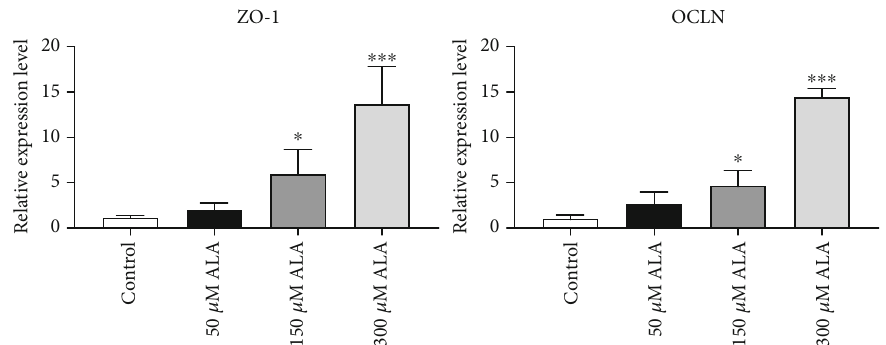
Figure 2: E ff ects of ALA on the mRNA expression of mucosal tight junction factors of NCM460 cells during injury repair. Quantitative real- time PCR analysis of tight junction protein 1 (ZO-1) and occludin (OCLN). ∗ P < 0 : 05 and ∗∗∗ P < 0 : 0001 .